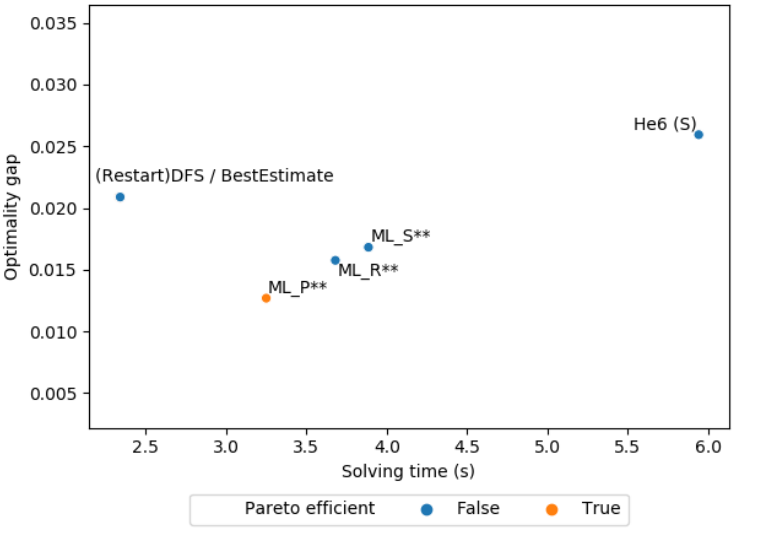
Figure A3. Combinatorial auctions: average solving time against the average optimality gap of the first solution found at a leaf node. ‘**’ p <